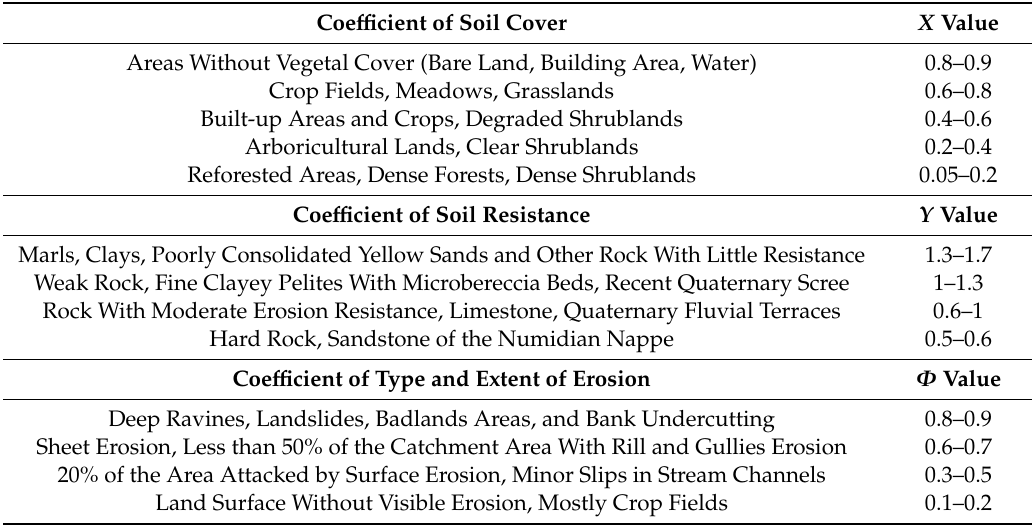
Table 3. Values of the factors used in the EPM / IntErO